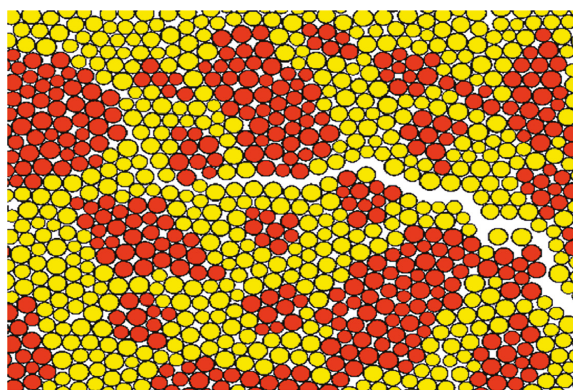
Figure 12: Local macrocrack extension of the upper surface